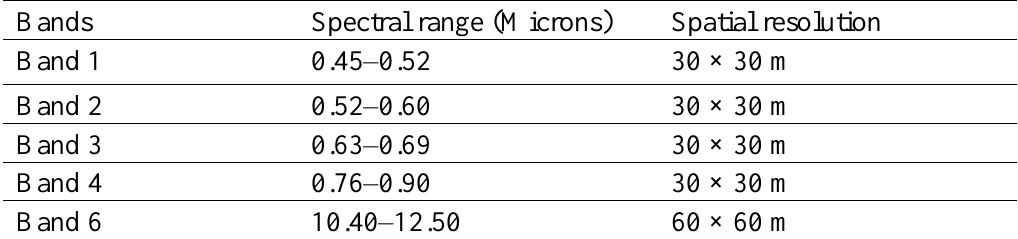
Table 1. Spectral range and spatial resolution of Landsat ETM +